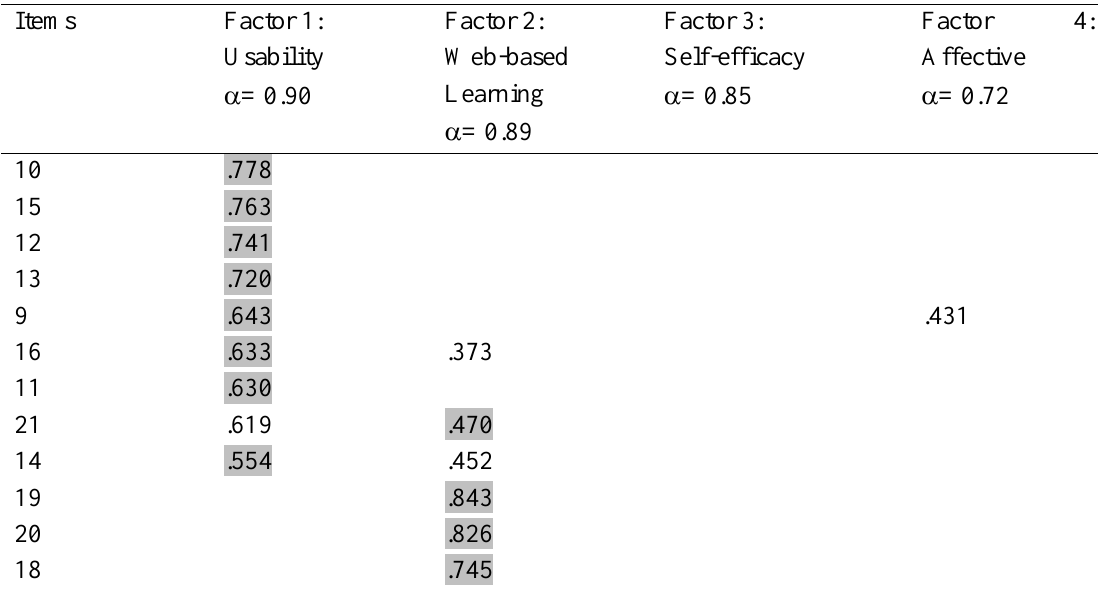
Rotated Factor Loadings and Cronbach’s  Coefficients for the Four Factors (Subscales) of the Web Attitude